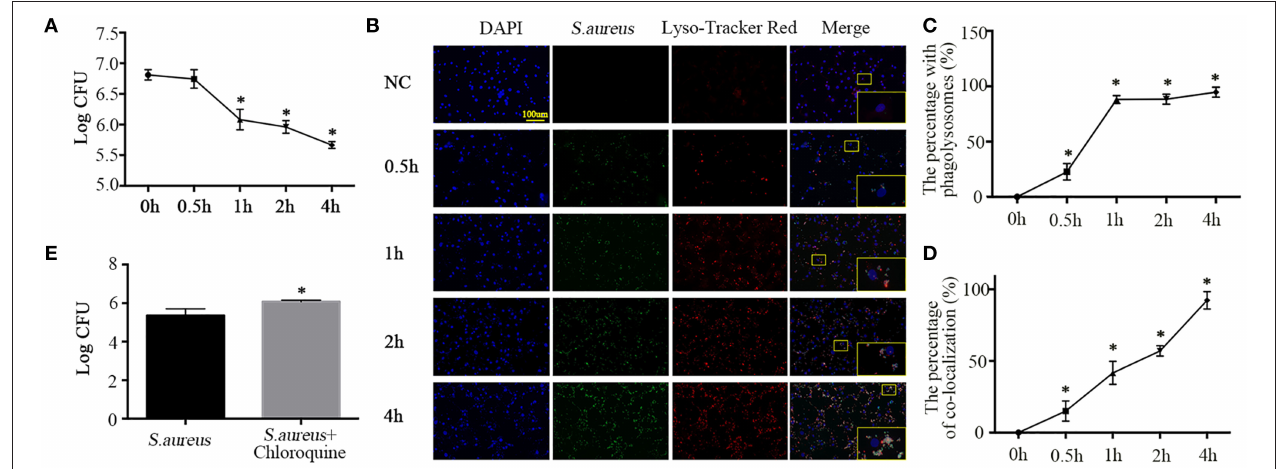
FIGURE 3 | Phagolysosome formation and microbicidal activity of NPCs. (A) Intracellular bacterial survival detected by plate counting. The bacterial survival rate is represented as the log CFU/mL. * P < 0.05, group of different time points vs. the group of 0h. Groups were compared by one-way ANOVA. (B) Immunofluorescence staining of Lyso-Tracker Red in NPCs infected with S. aureus for different time points (0, 0.5, 1, 2, 4h). (C,D) The percent with phagolysosomes and the percent of co-location increased gradually over time. * p < 0.05, the 0h group vs. the different groups. Groups were compared by one-way ANOVA. (E) Intracellular bacterial survival detected by plate counting. NPCs were induced by S. aureus at a MOI = 1:10 for 1h after pretreatment with chloroquine (25 µ M) for 6h, after which unattached S. aureus were removed by washing with ice-cold PBS, lysostaphin, and trypan blue, and then warm F12-DMEM medium was added. The intracellular bacterial survival was determined after 4h. * P < 0.05, the group of S. aureus + chloroquine vs. the group of S. aureus . P values were determined by T -test. All data are presented as the means ± S.D from three independent experiments.